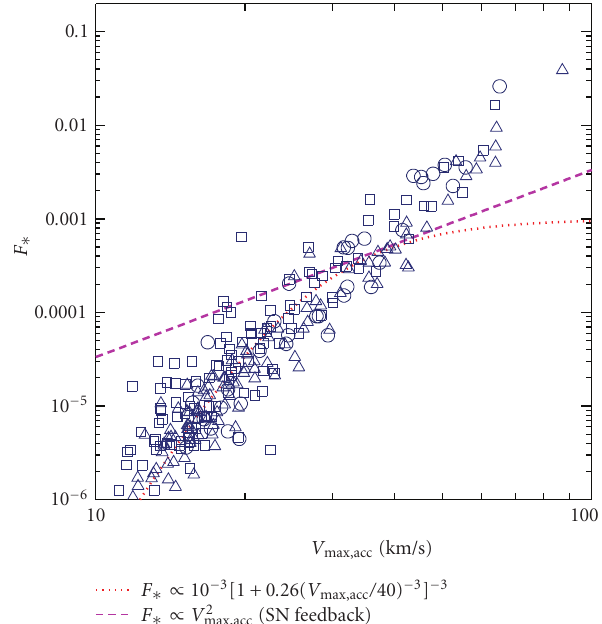
Figure 14: The e ffi ciency of gas conversion into stars, defined as the fraction of baryon mass, expected if the halo accreted its universal fraction of baryons, converted into stars: F ∗ = ( Ω m / Ω b )( M ∗ /M vir,acc ). The points (as before di ff erent symbols correspond to subhalos in three di ff erent simulated host halos) show the dependence of F ∗ on the maximum circular velocity of each subhalo at accretion according to luminosity assignment model of (4). The short-dashed line shows the functional form expected if F ∗ was controlled by the suppression of gas accretion due to UV heating of intergalactic gas (model 3B of [84]), while long-dashed line shows scaling expected in e ffi ciency was set by supernova feedback (e.g.,